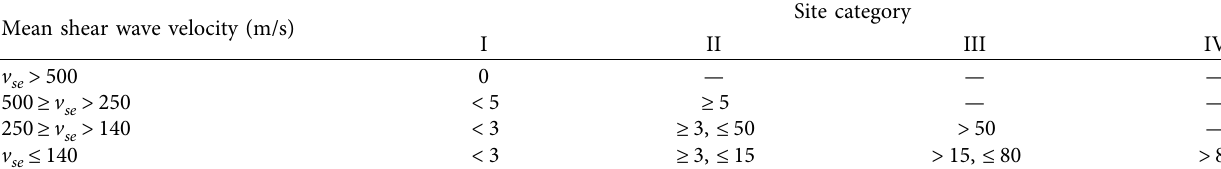
Table 2: Classification of engineering sites.